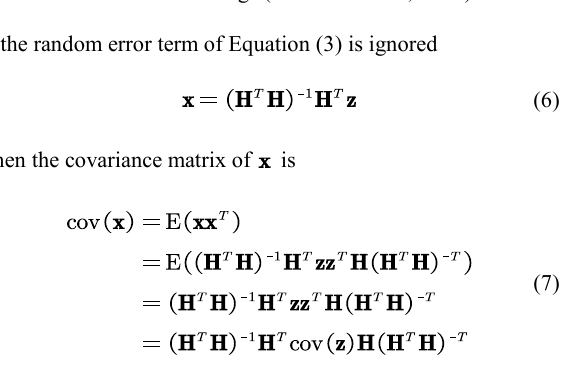
Table 1 . DOP ratings (Tahsin M et al.,